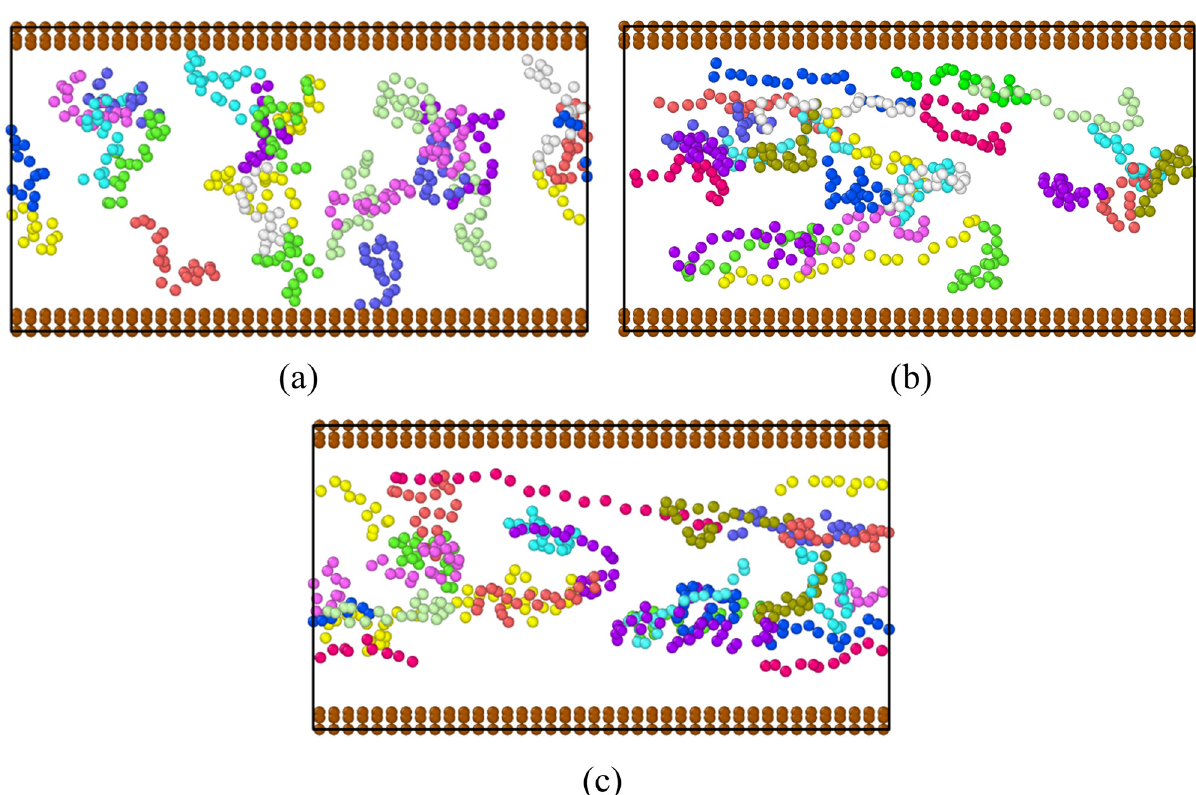
Figure 3: Snapshots for wormlike chains for varying values of the driving force at the last time step: ( a ) f = 0, ( b ) f = 0.1, and ( c ) f = 0.2. Here di ff erent chains are shown in di ff erent colors.